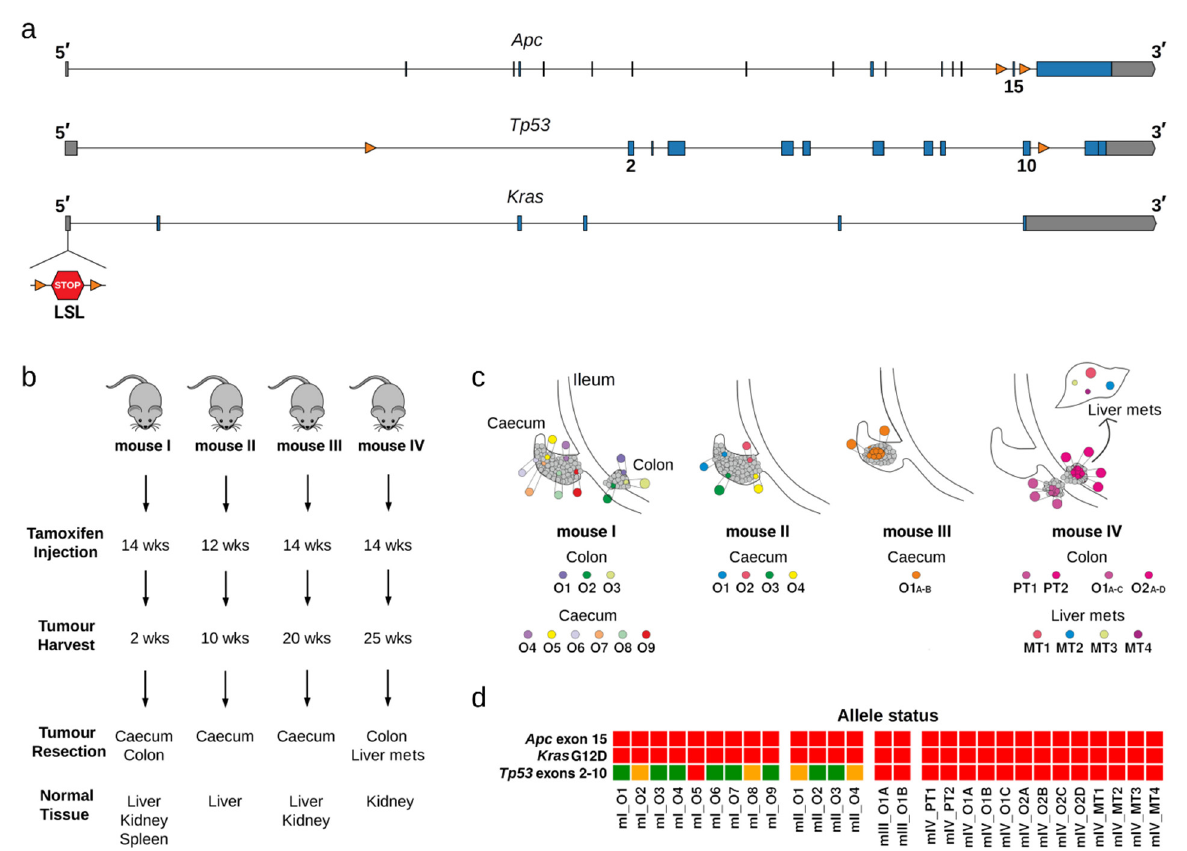
Figure 1. Colorectal carcinoma (CRC) mouse model, resected samples, and genotype of organoids. ( a ) Structure of the conditional alleles Apc lox/lox , Tp53 lox/lox , and LSL-Kras G12D . Blue boxes and orange triangles indicate exons and loxP sites, respectively. ( b ) Four 3–4-month-old mice were injected with tamoxifen to initiate tumour development. Caecum and colon tumours were obtained for subsequent isolation of intestinal single cells. Normal tissue was also resected and used as control sample during sequencing analysis. Mouse IV developed metastatic lesions in the liver and metastatic tumour samples were also resected and sequenced. ( c ) Multi-region sampling of each mouse is illustrated by coloured labels. PT: primary tumours, MT: metastasis, O: tumour organoids. ( d ) Recombination events in organoids validated by PCR-based genotyping and by read depth analysis of sequencing data. Red, orange, and green colour indicate homozygous, heterozygous and no recombination for Apc lox/lox and Tp53 lox/lox , respectively. For LSL-Kras G12D , red colour represents recombination of the conditional allele.